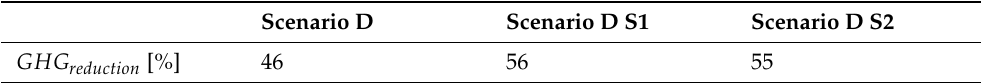
Table 6. GHG emissions Scenario